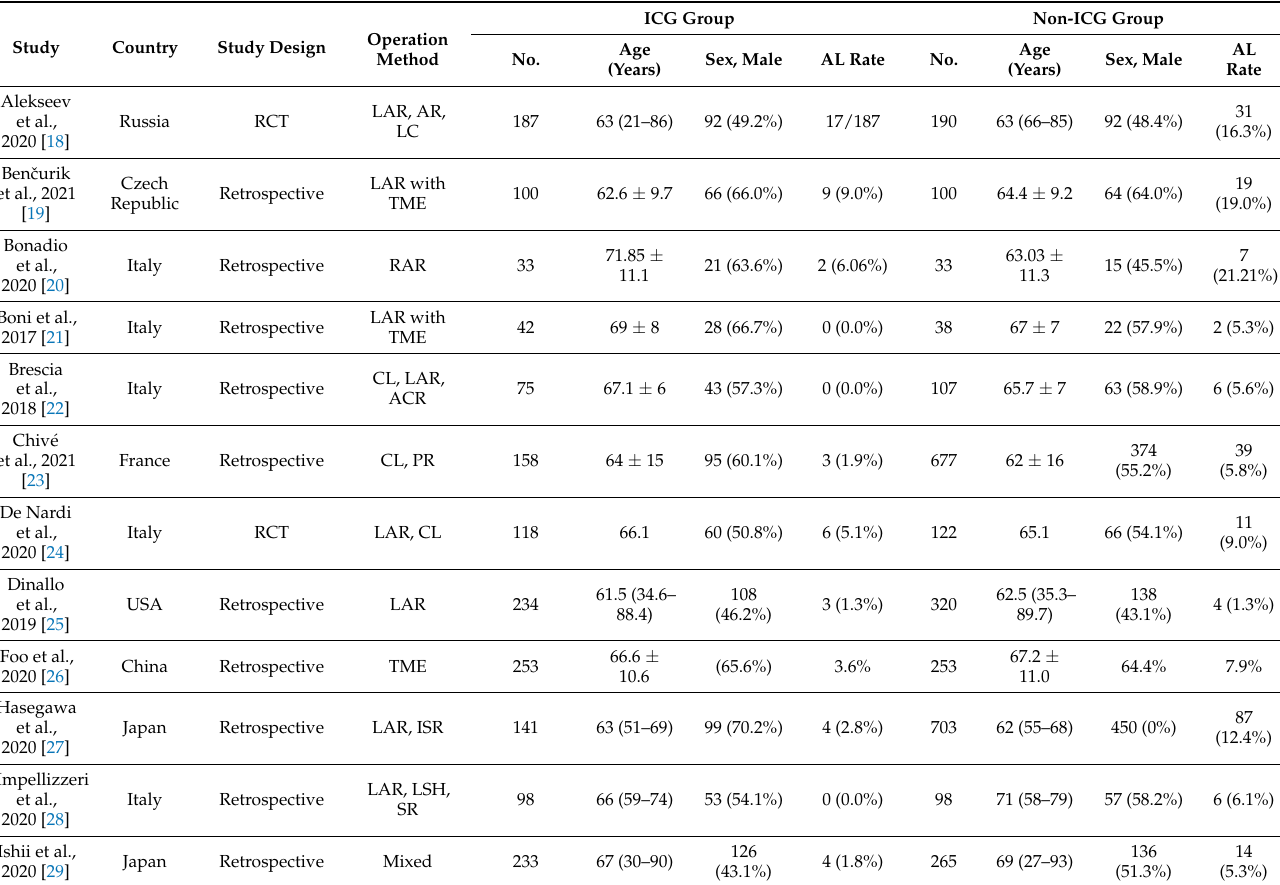
Figure 1. Database search and selection of studies in accordance with the PRISMA guidelines. Table 1. Characteristics of the included